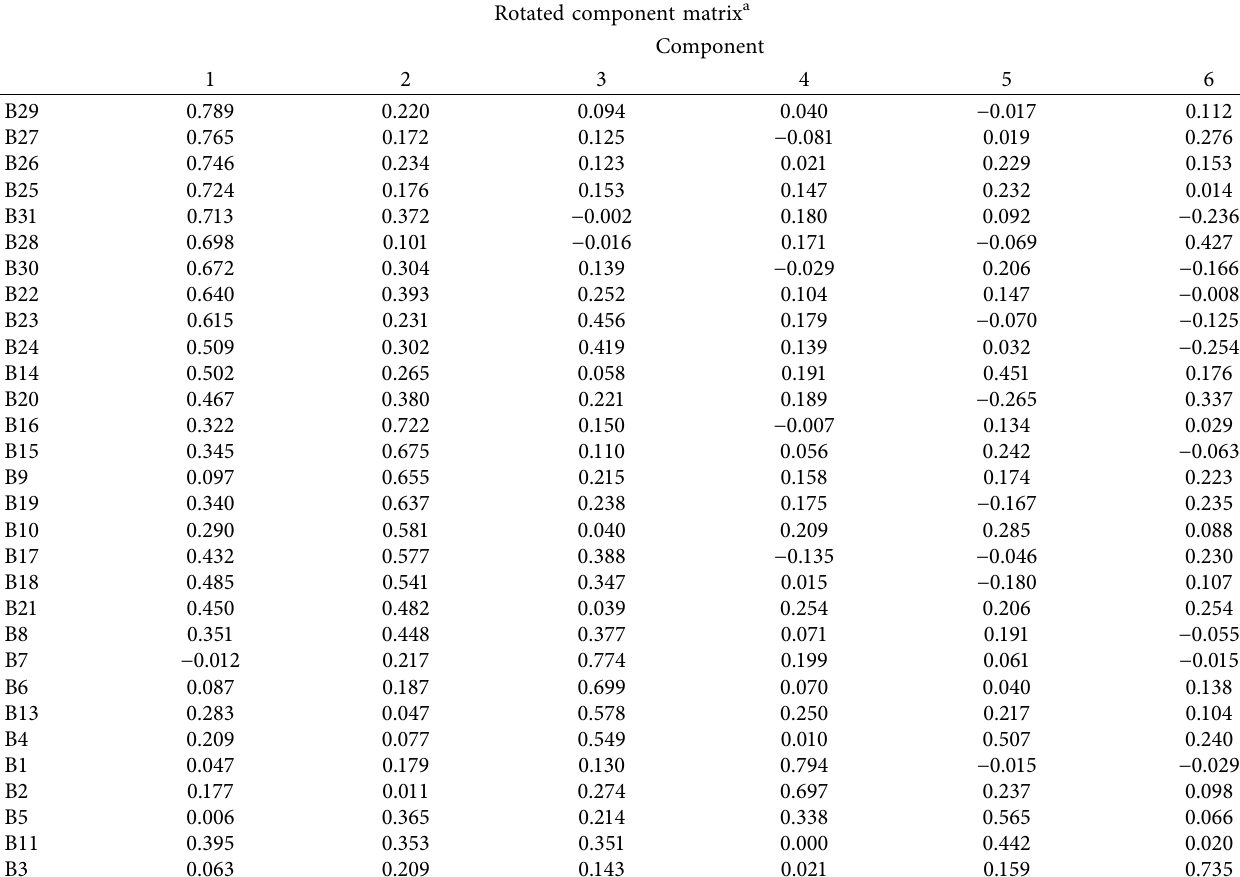
Figure 4: Scree plot for testing common component extraction. Table 9: Rotated component